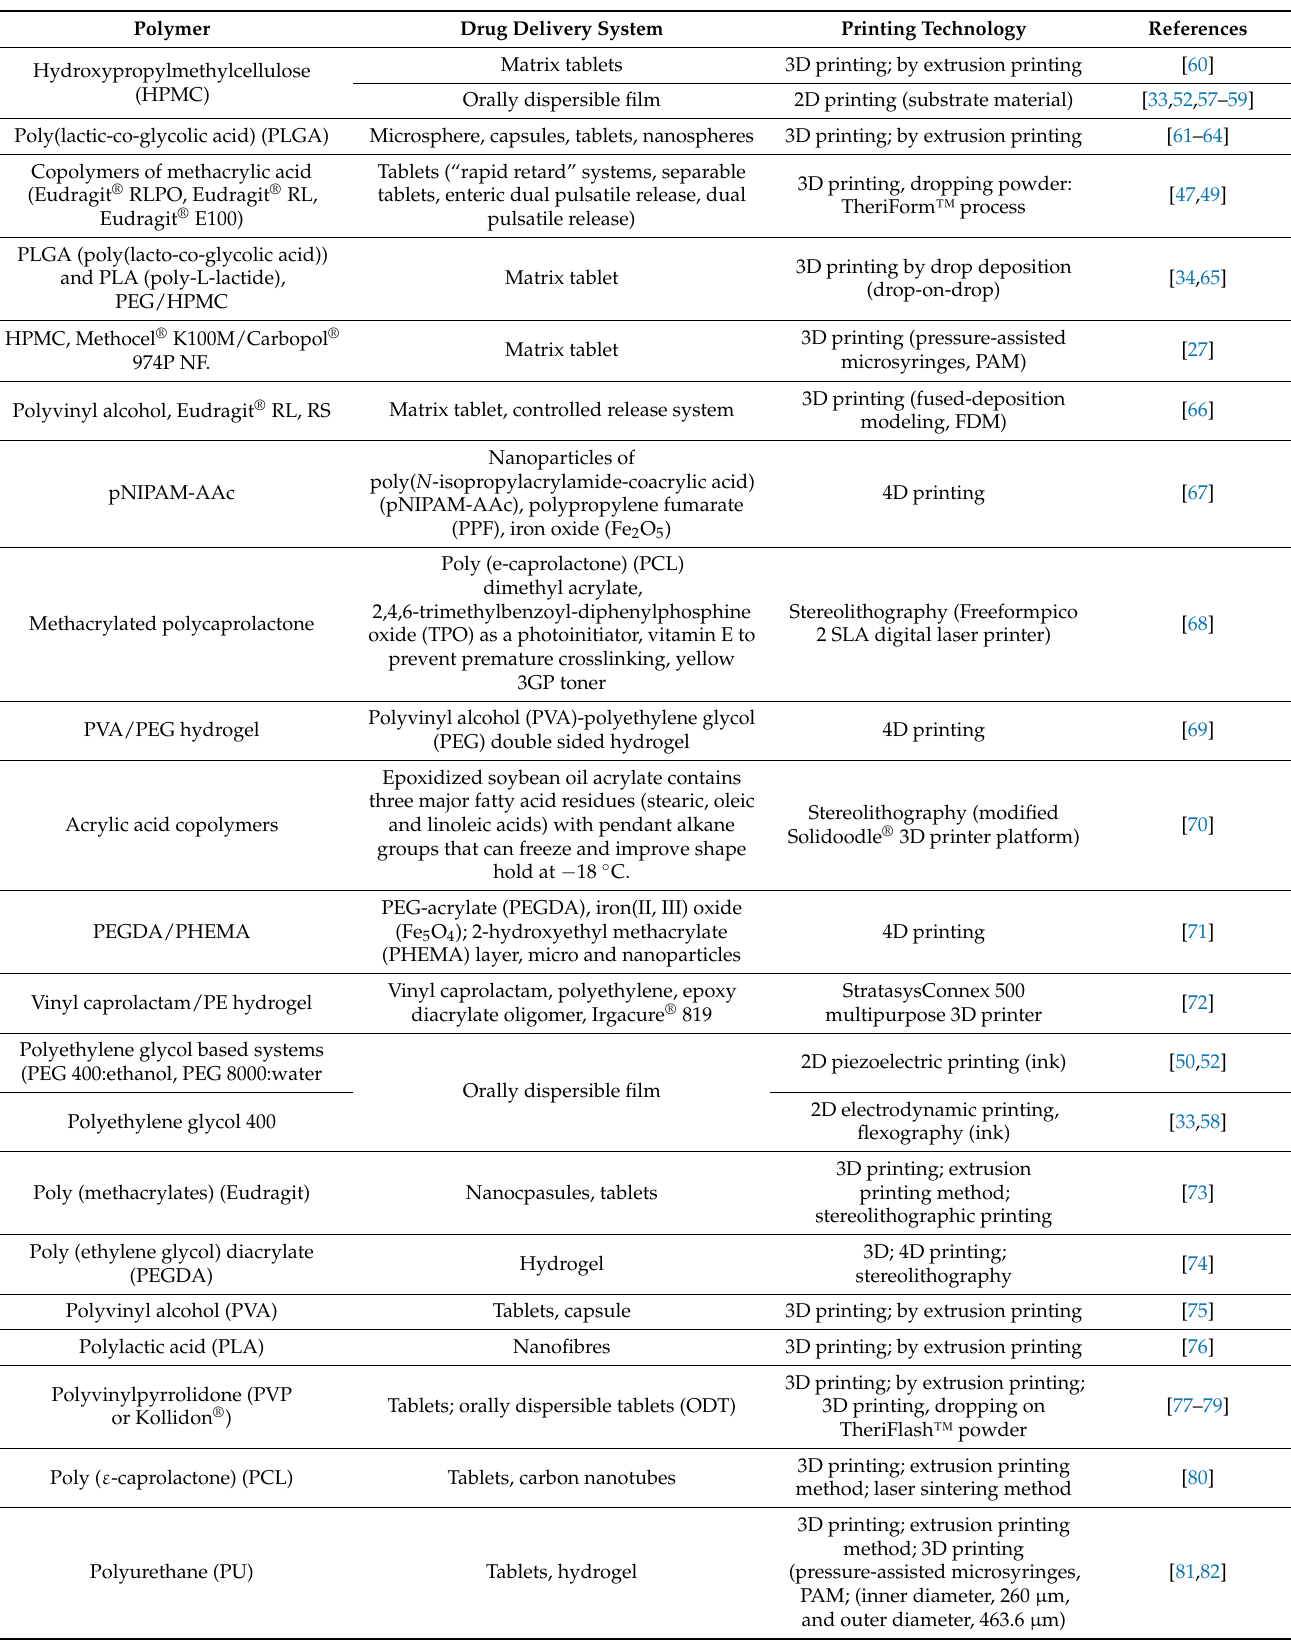
Table 2. Polymers used to obtain dosage formulations for personalized